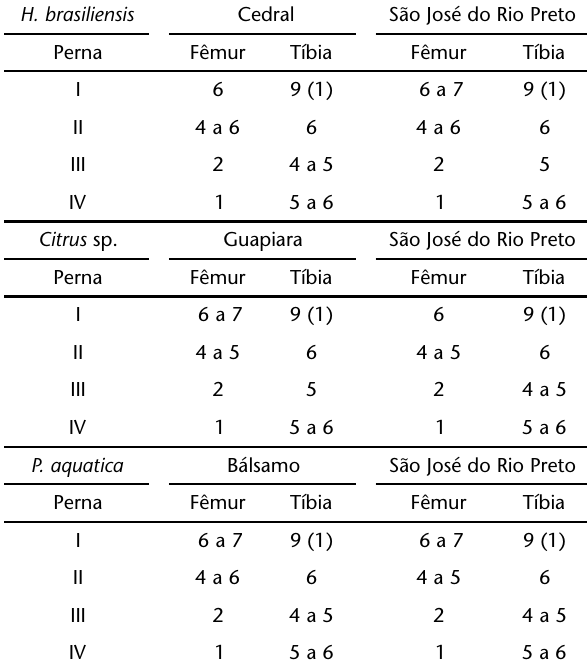
Tabela IV. Variação na quetotaxia das pernas I a IV das fêmeas de E . banksi oriundas de H . brasiliensis , Citrus sp. e P . aquatica dos municípios de São José do Rio Preto, Cedral, Guapiara e